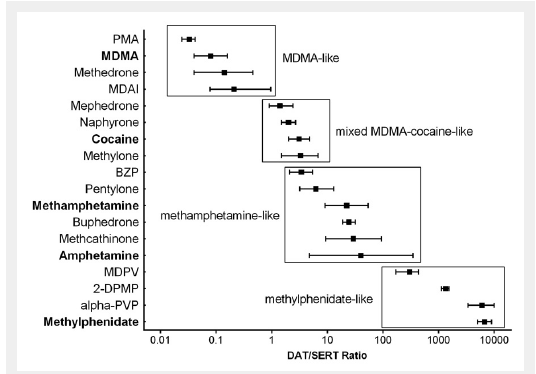
Relative dopamine/serotonin inhibition potencies of selected novel psychoactive substances. Dopamine to serotonin transporter (DAT/ SERT) inhibition ratios (mean ± 95% confidence intervals) for novel substances are shown in comparison with those of classic empathogens/entactogens (MDMA, ecstasy) and stimulants (cocaine, amphetamine, and methamphetamine). The ratios derived from in vitro studies help to predict the typically unknown clinical toxicity of novel substances. A low DAT/SERT inhibition ratio (<0.1) indicates tenfold greater relative serotonergic vs dopaminergic activity similar to MDMA. A high DAT/SERT inhibition ratio (>10) indicates greater relative dopaminergic vs serotonergic activity similar to methamphetamine. A high DAT/SERT inhibition ratio is a pharmacological characteristic associated with more stimulant effects and with higher potential for